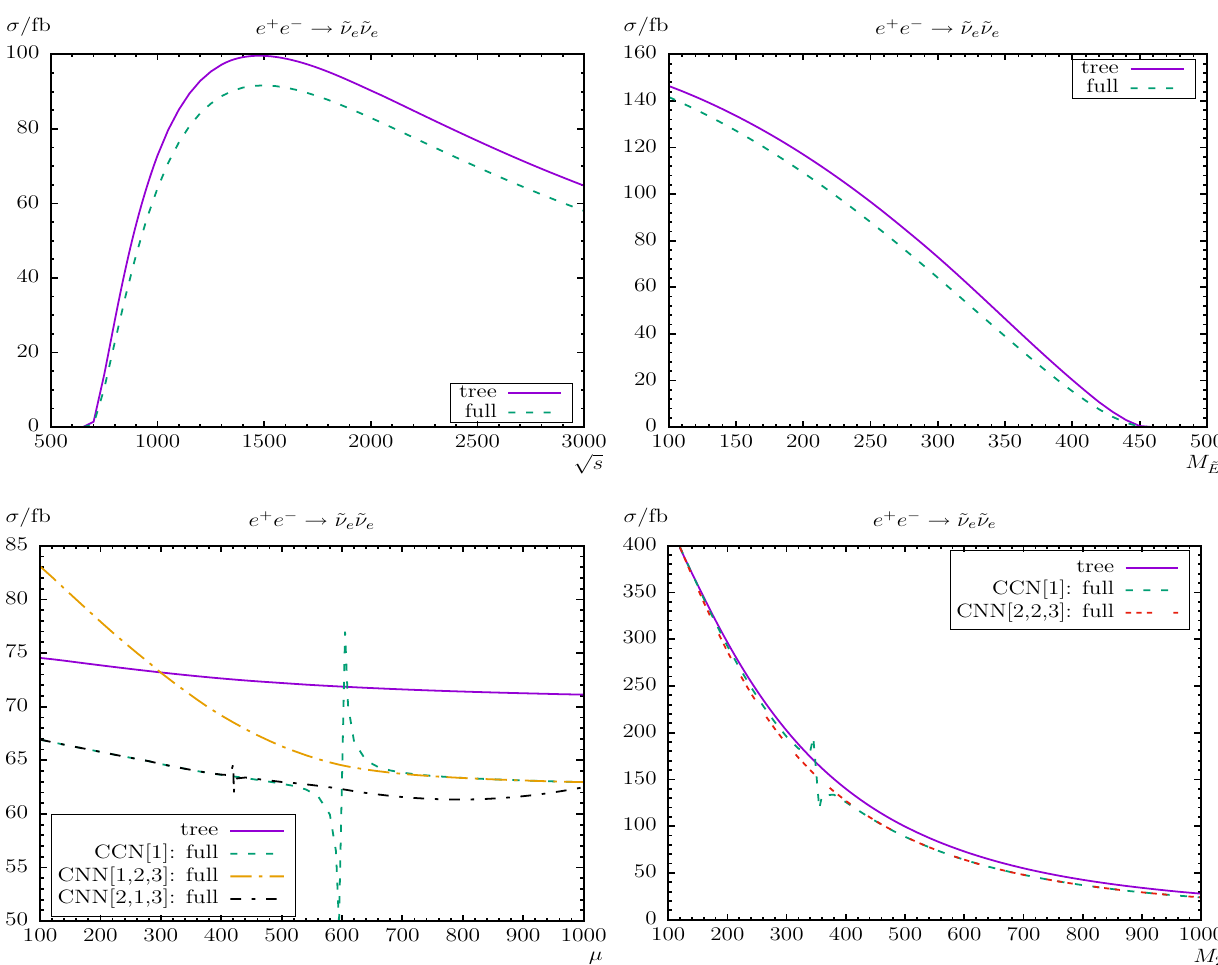
√ s (left) and M ˜ (right) varied; the lower plots show μ (left) and M 2 (right) varied. All masses and E